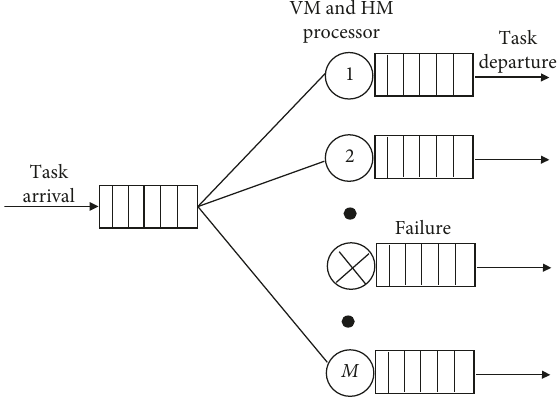
Figure 2: Multiprocessor working mechanism.